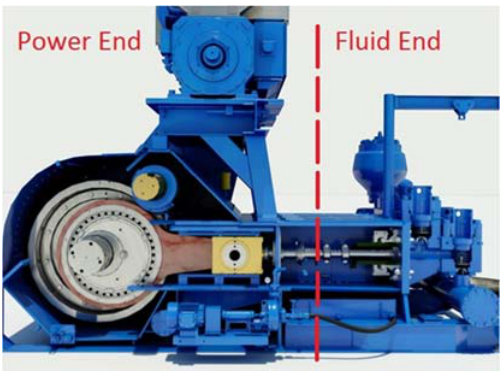
Figure 5. The mud pump made by NOV, divided into two most important components [7].